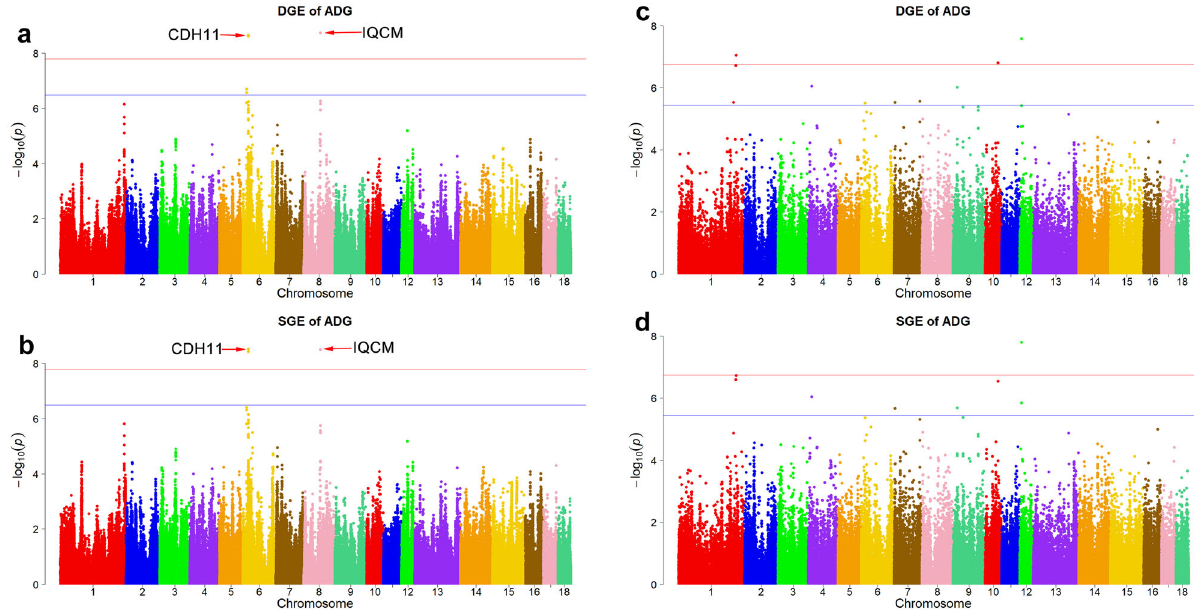
Fig. 5 GWAS results for direct genetic effects (DGE) and social genetic effects (SGE) in average daily gain (ADG). a for DGE using imputed-GWAS; b for SGE using imputed-GWAS; c for DGE using haplotype-based GWAS; d for SGE using haplotype-based GWAS. For imputed-GWAS, the horizontal red and blue lines indicate the genome-wide (1.63 × 10 − 8 ) and suggestive (3.25 × 10 − 7 ) level, respectively. For haplotype-based GWAS, the horizontal red and blue lines indicate the genome-wide (1.82 × 10 − 7 ) and suggestive (3.64 × 10 − 6 ) level, respectively.